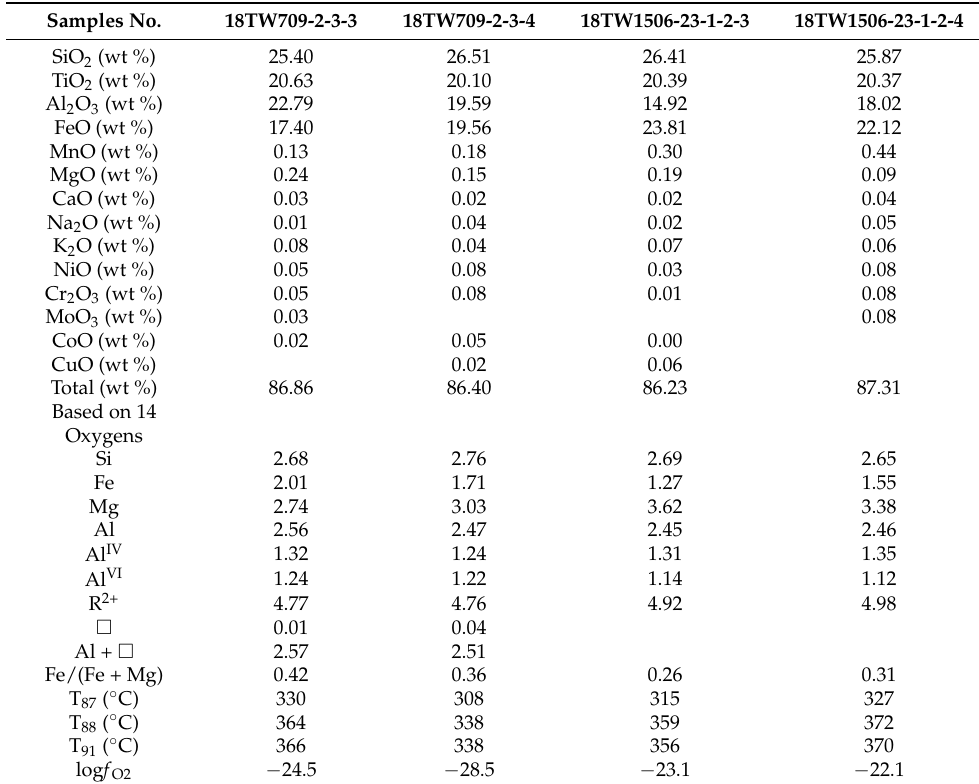
Table 3. Geochemical compositions of hydrothermal chlorite and calculated temperatures. Samples